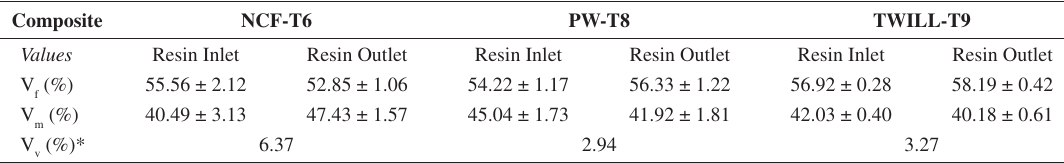
Figure 7. Epoxy resin system (Cycom 890 RTM) profile Table 2. Acid digestion and porosimetry composites data.